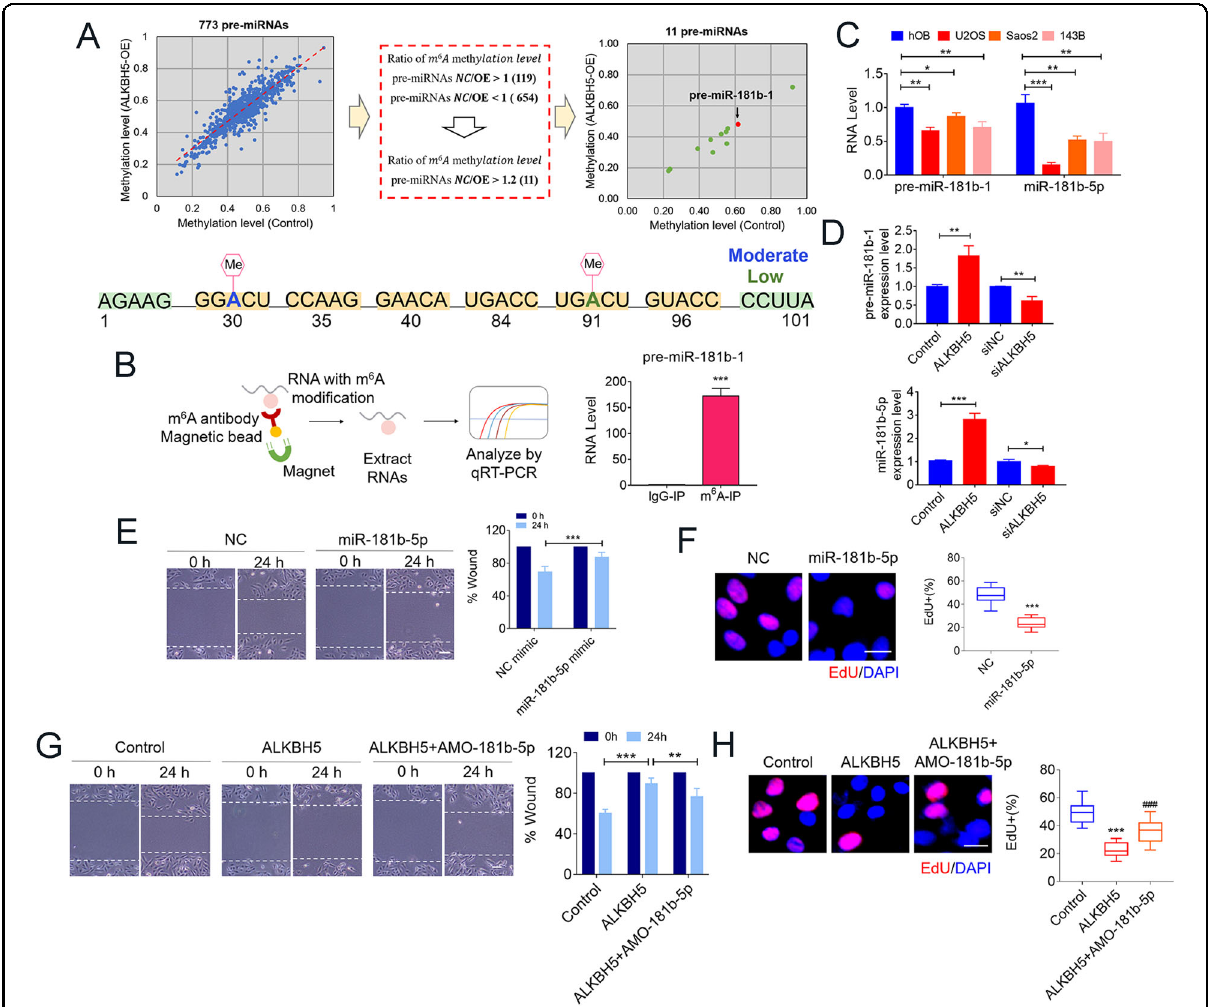
and miR-181-5p. A m 6 A-RIP microarray analysis (upper) showing inhibitory effects of ALKBH5 on m 6 A methylation of pre-miRNAs relative to the control group. Two potentially m 6 A sites of pre-miR-181b-1 predicted by SRAMP program (lower). B m 6 A methylation modi fi cation of miR-181-5p detected by gene-speci fi c m 6 A assay. C pre-miR-181b-1 and miR-181-5p endogenous levels in osteosarcoma cell lines compared with hOB cells. D qRT-PCR analysis revealed the function of ALKBH5 overexpression or knockdown on pre-miR-18b-1 and miR-181-5p expression. E Wound-healing assay performed at 0 and 24 h, respectively, after transfected with NC or miR-181-5p mimics. Bar graph representing mean relative distance of migrated cells (Bar: 200 μ m, n = 4). F Representative images of EdU staining in U2OS cells with or without miR-181-5p mimics. Bar graph quantifying the percentage of EdU-positive cells (Bar: 25 μ m, n = 5). G Migration ability of U2OS after transfected with ALKBH5 plasmids and/or co-transfected with miR-181-5p inhibitor (AMO-181-5p) (Bar: 200 μ m, n = 4). H EdU staining showing the reversing effects of AMO-181-5p on cell proliferation (Bar: 25 μ m, n = 5). Data are expressed as mean ± SEM. * P < 0.05; ** P < 0.01; *** P < 0.001 (vs. the fi rst group). ### P < 0.001 (vs. the second